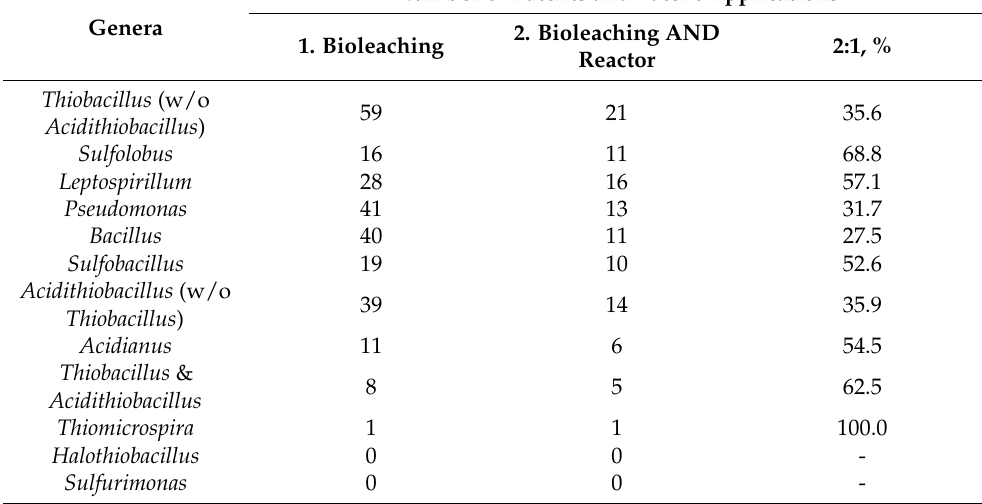
Table 3. Number of the Russian patents and patent applications (1991–2022) found by keywords “bioleaching” or “bioleaching AND reactor” together with the generic names of microorganisms in the Russian Federal patent database FIPS (https://www.fips.ru/iiss/search.xhtml, accessed on 28 November